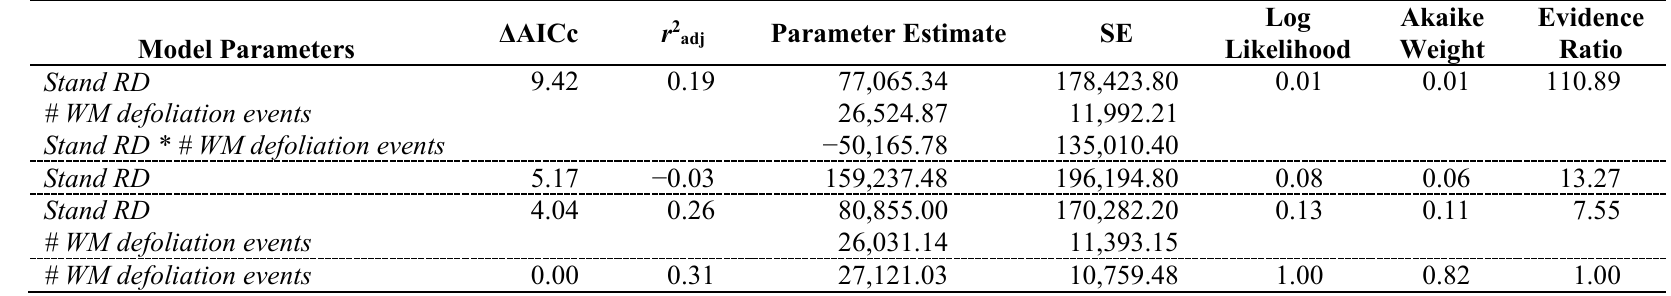
Table 5. Results of multiple regression on Understory Density at 13 sites in eastern Massachusetts; ΔAIC c = corrected Akaike Information Criterion differences; SE = standard